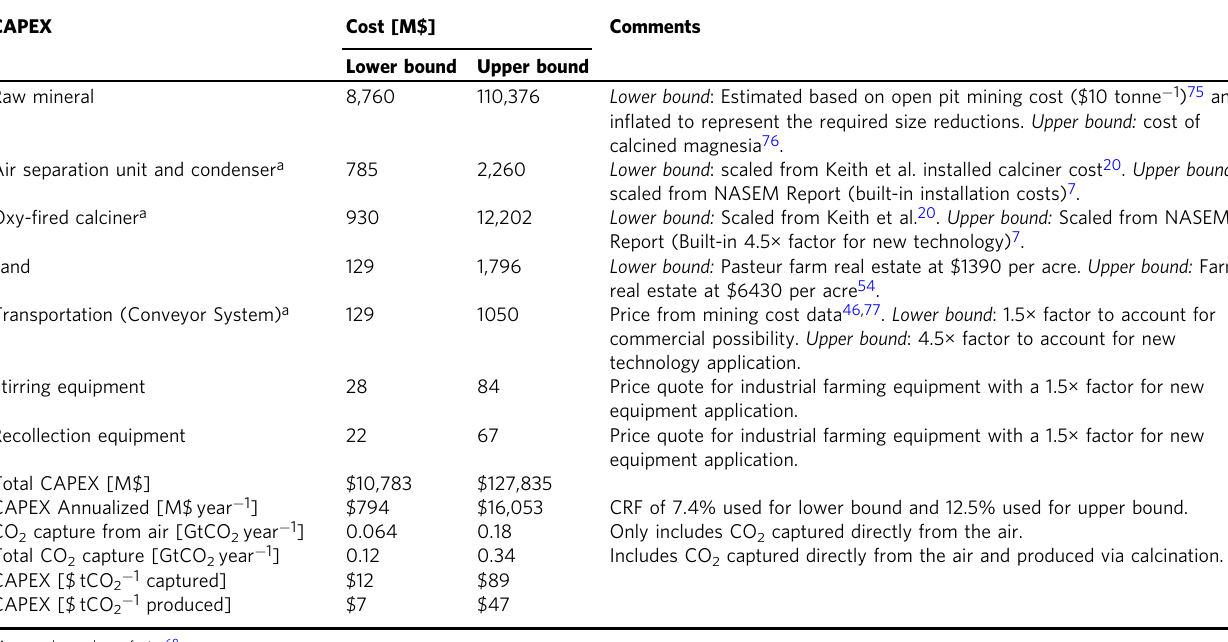
Table 2 Estimated capital expenditures (CAPEX) for the MgO looping process.